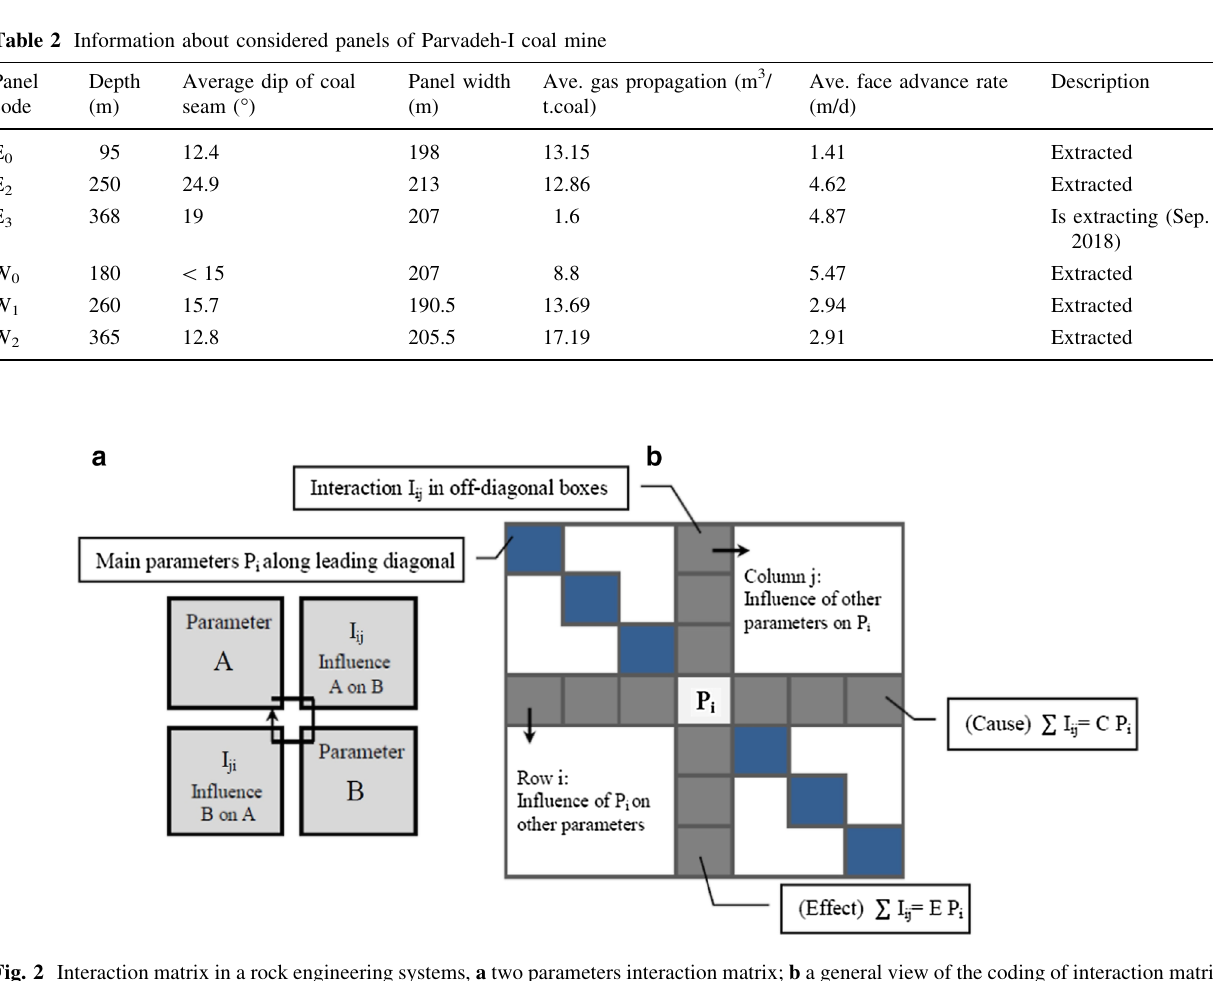
Fig. 2 Interaction matrix in a rock engineering systems, a two parameters interaction matrix; b a general view of the coding of interaction matrix (Faramarzi et al.